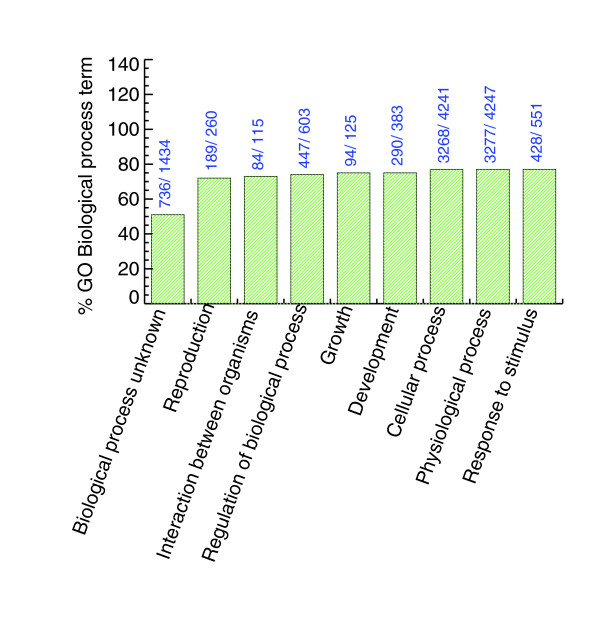
The number of genes identified in GO Biological Process terms (more specifically, the first level children). The bars are annotated with the number of SGD genes and the number of SGD genes in PeptideAtlas for that term.